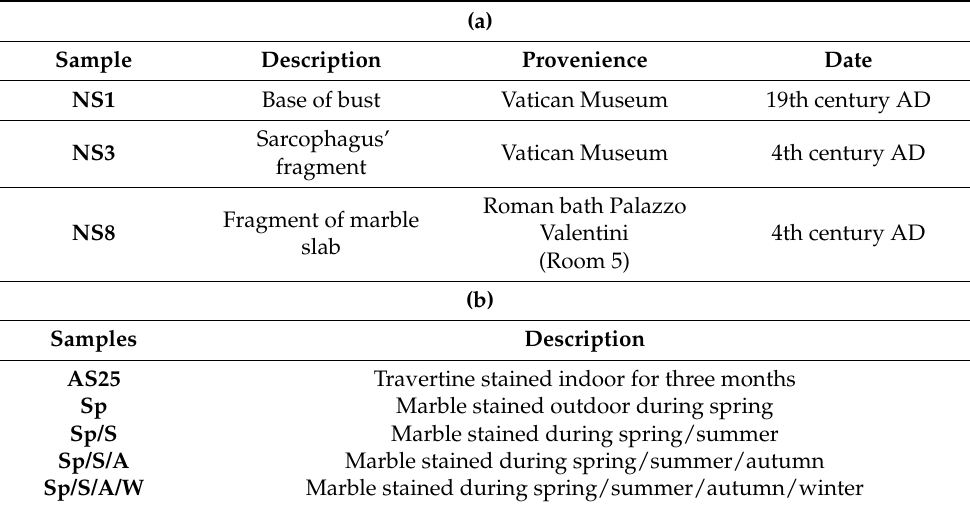
Table 4. ( a ) Archeological samples. ( b ) Artificially stained